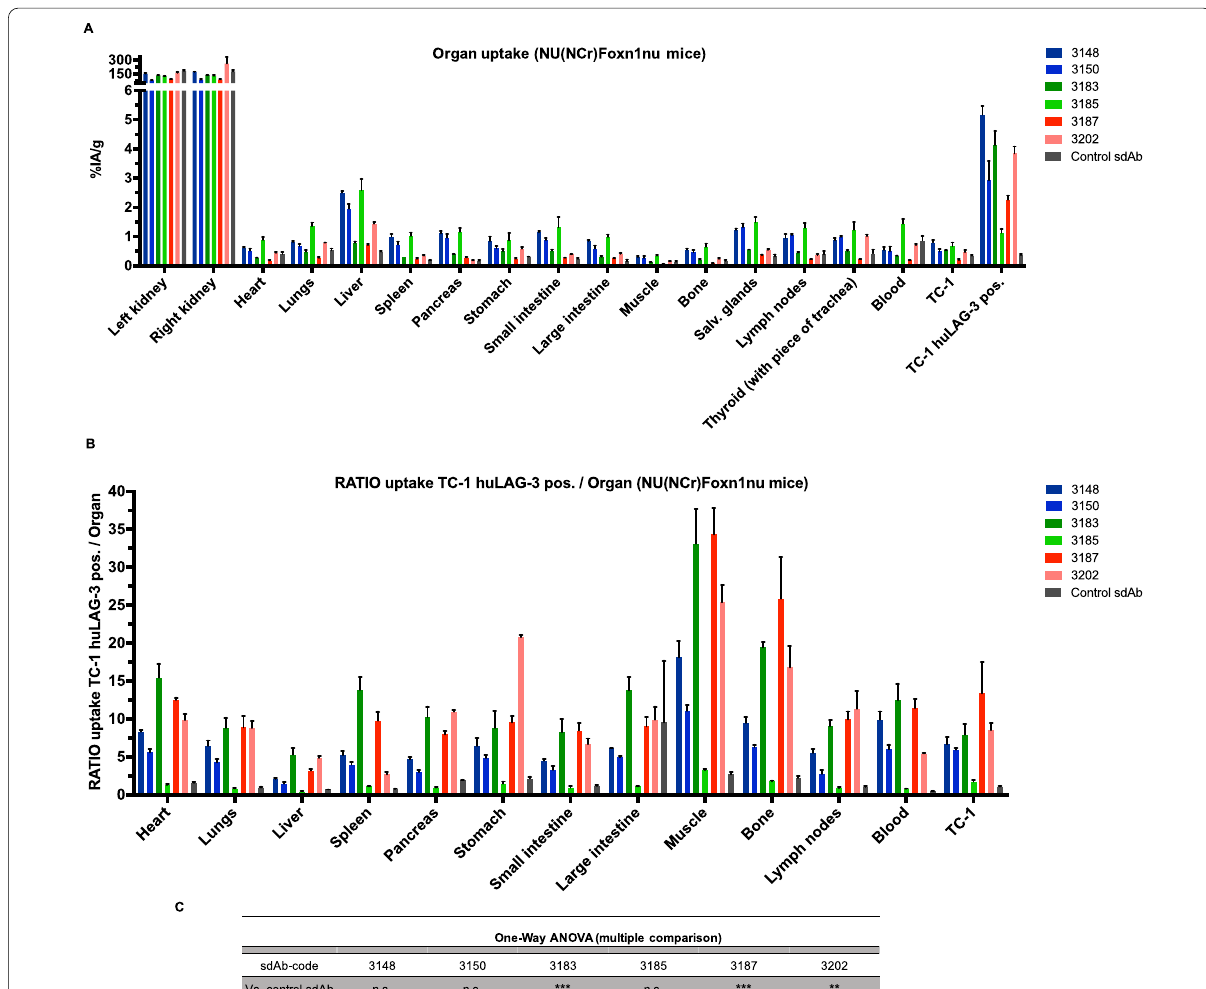
Fig. 6 SdAb-mediated SPECT/CT imaging in TC-1-huLAG-3 tumor bearing mice shows that sdAb 3187 generates high signal-to-background ratios enabling detection of huLAG-3 in the tumor. A Results of ex vivo γ -counting analysis of uptake in isolated organs (expressed in %IA/g and as mean SD ( n 3)). B The graph shows the ratio in uptake in the TC-1-huLAG-3 positive tumor compared to the indicated organs. C The table ± = shows the statistical results of comparing TC-1-huLAG-3 positive tumor/organ ratio values between control sdAb and huLAG-3 targeting sdAbs, confirming significant differences for sdAbs 3187 and